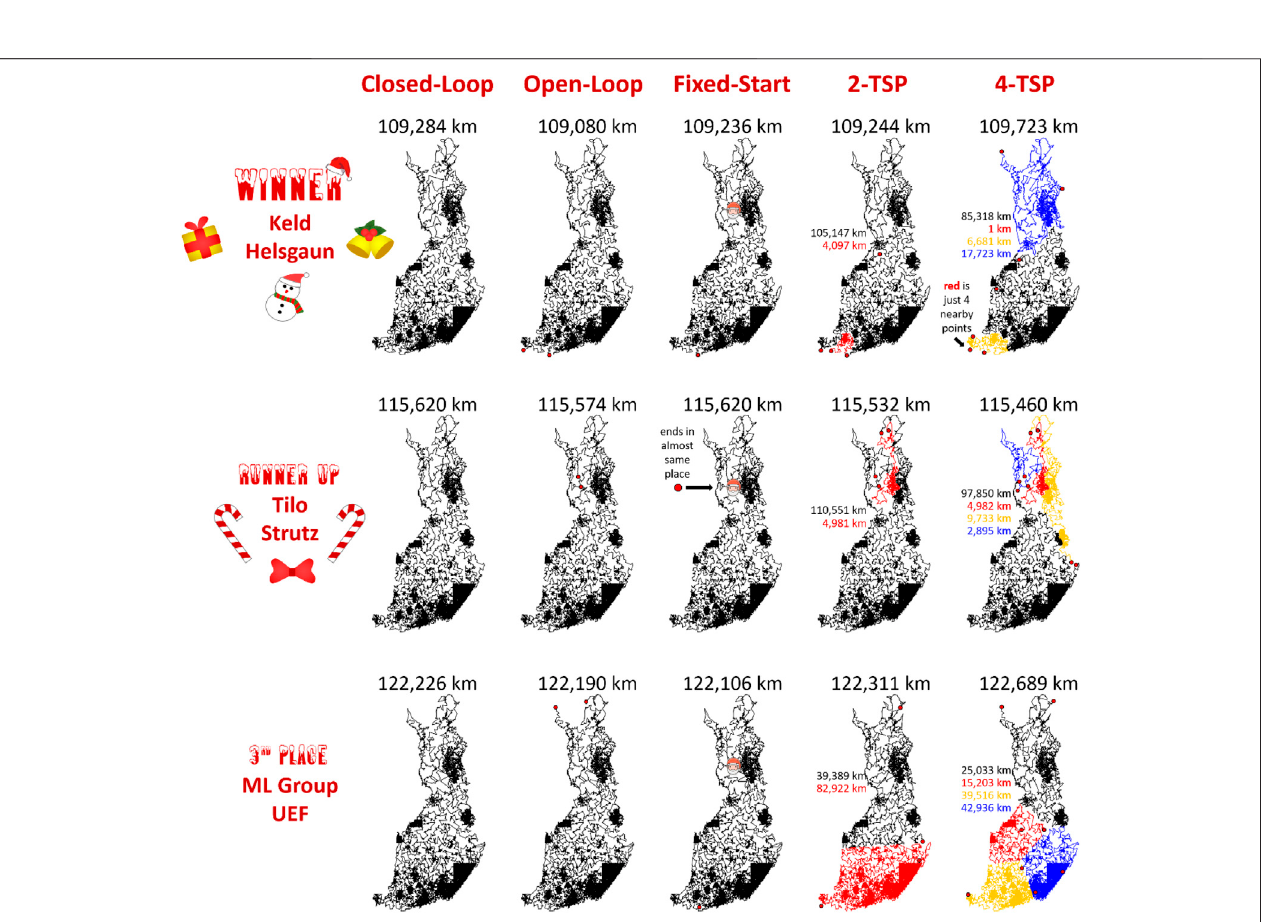
FIGURE 14 | Summary of the results of the Santa competition. The difference between the 1st (109,284 km) and the 3rd (122,226 km) is approximately 12%. When repeated 10 times, the standard deviations of the results were only 98 km (LKH), 47 km (DoLoWire) and 143 km (TSP Div), which shows that the effect of randomnessisnegligible, whichoriginates fromthelargenumberoftrialoperators applied andthelarge problemsize.According toANOVA, theresultswerestatistically signi fi cant ( p < 10 30 in all cases).